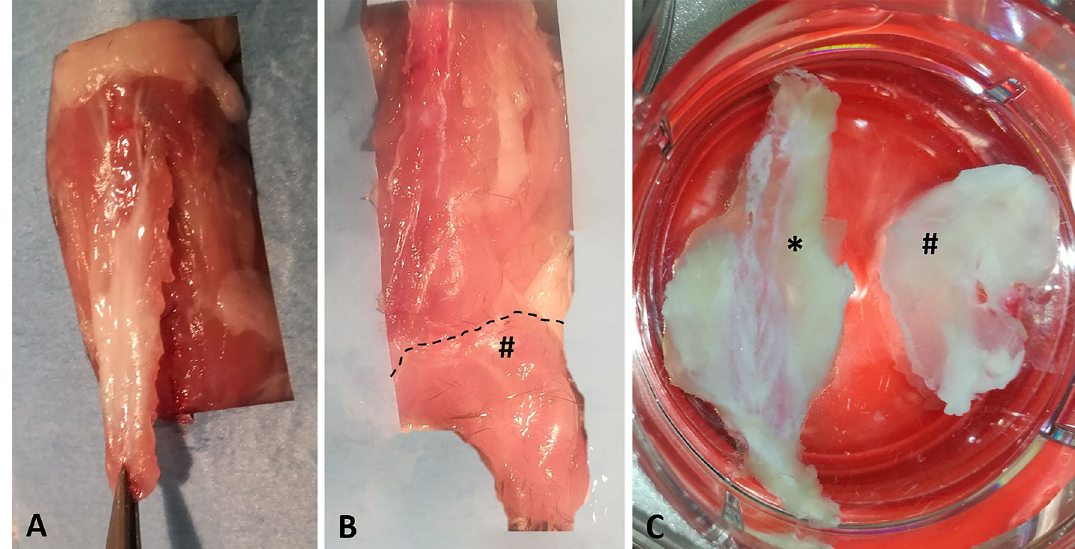
Figure 9. Samples collection and macroscopic images of thoracolumbar fascia and gluteal fascia: ( A ) collection of thoracolumbar fascia; ( B ) collection of gluteal fascia (#); ( C ) floating samples of thoracolumbar fascia (*) and gluteal fascia